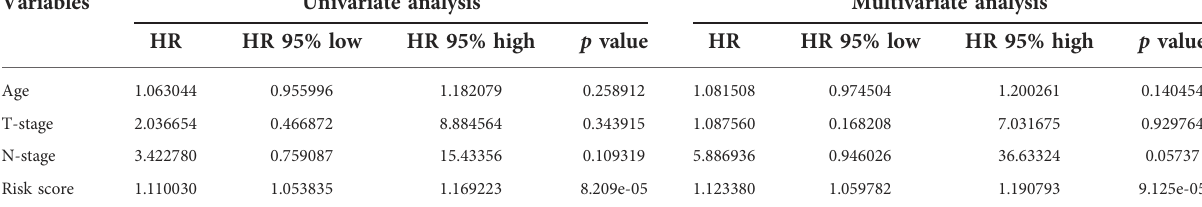
TABLE 2 Univariate and multivariate analyses of PCa.